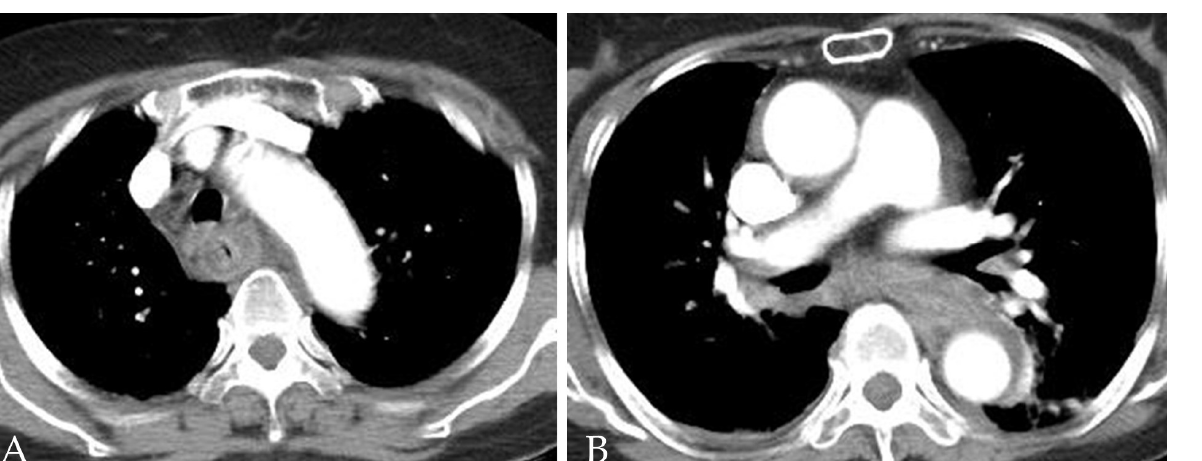
Medicina 2022 , 58 , x FOR PEER REVIEW 2 of 7 nal fat attenuation, and peri-esophageal fluid collection (Figure 1). Esophagitis and medi- astinitis were highly suspected, but there was no evidence of esophageal perforation. CT